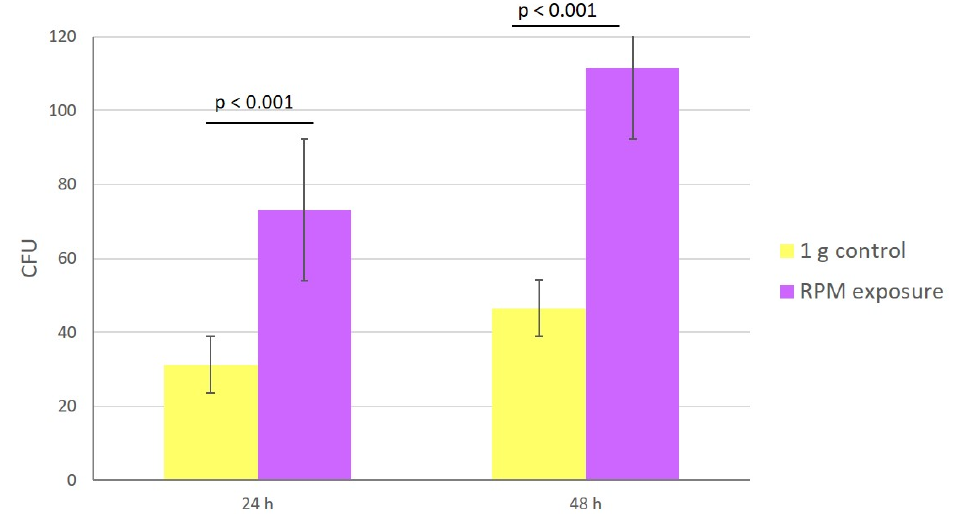
Figure 2. Impact of microgravity on fungal growth. Number of CFUs after 24 and 48 h of culture under simulated microgravity (purple) or 1 g control (yellow) conditions. The experiment was performed twice for all 8 strains subjected to 1 g control or RPM conditions. Data are the mean ± SEM. Statistically significant differences were observed using the Student’s t test.